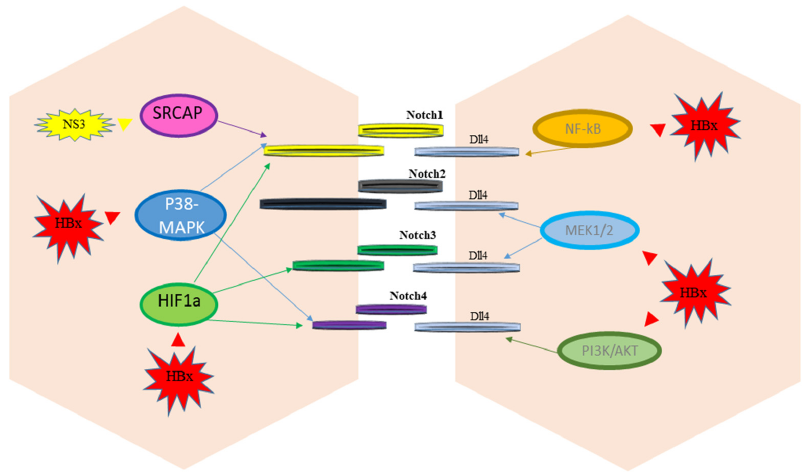
Figure 2. Notch signaling regulation by hepatitis viruses.